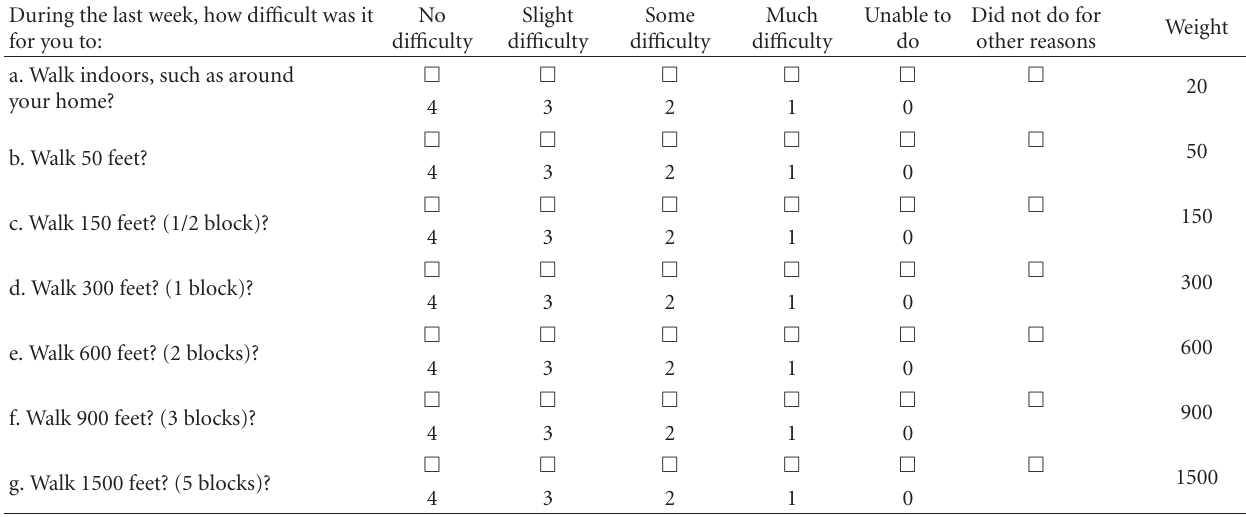
Table 6: Distance subscale of the